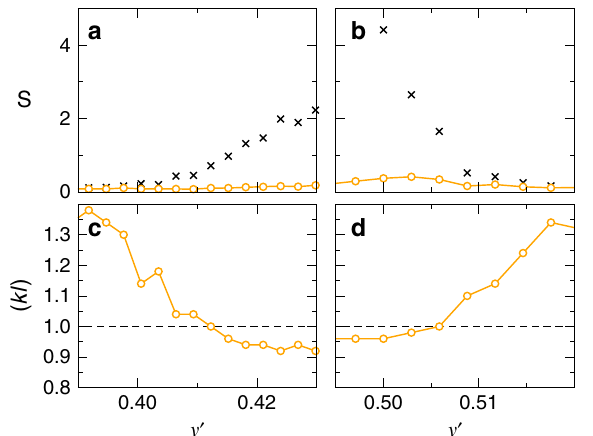
Fig. 4 Two-parameter fi t to the self-consistent (SC) theory of localization. Fitting error S for a comparison to diffusion theory (crosses) and SC theory (open circles) for frequencies below the gap frequency ν Gap ( a ) and above ( b ). Adjustable parameters are ( c , d Localization parameter ( kl ) extracted from the fi t for the same frequency intervals. We fi nd ( kl ) = 1 for ν 0 c ; l ¼ 0 : 412 ( ℓ c , l / a = 0.513), ( c ), and ν 0 c ; h ¼ 0 : 506 ( ℓ c , h / a = 0.242), ( d ).